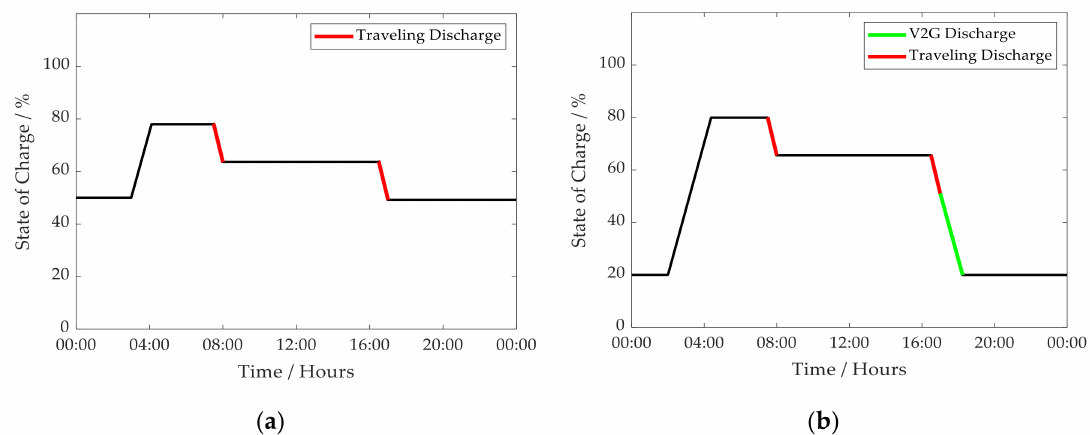
Figure 3. A visual comparison between the two drive cycles used throughout this study: ( a ) the baseline as late as possible (ALAP) drive cycle; ( b ) the V2G-optimised drive cycle.